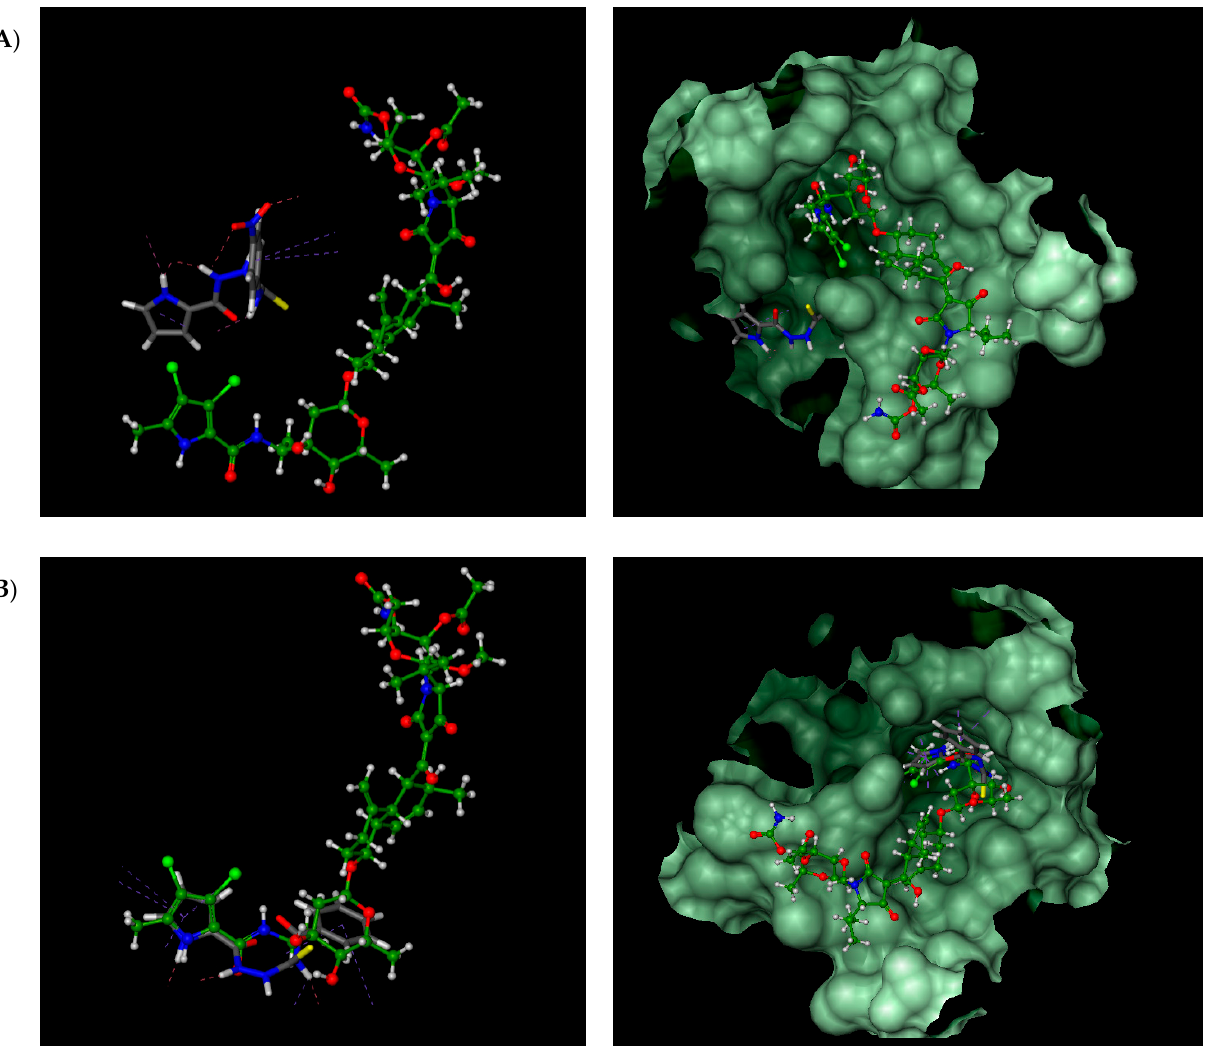
Figure 5. Overlay of calculated binding modes of thiosemicarbazides (in grey): ( A ) 3 ; ( B ) 6 and native kibdelomycin (in green) in the ATP binding pocket of S. aureus GyrB (PDB entry: 4URM). Remaining thiosemicarbazides are predicted to bind in manner similar to 6 ( 2 , 4 , 7 , and 9 ) or to 3 ( 1 and 5 ), respectively.